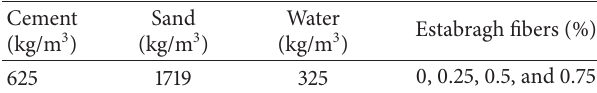
Table 2: Mortar mixture proportions (kg/m 3